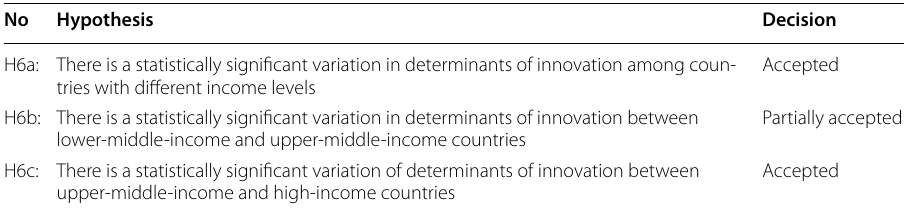
Table 9 Hypotheses test results